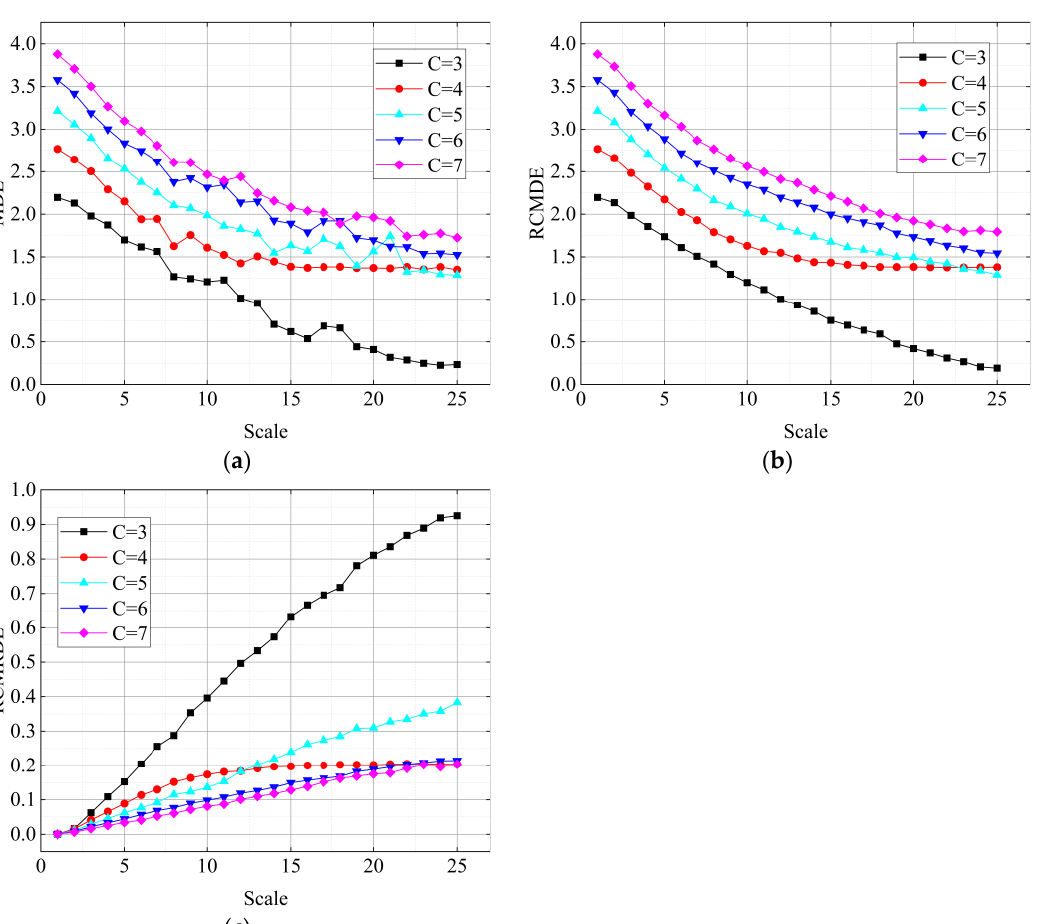
Figure 3. MDE, RCMDE, RCMRDE of WGN noise under different numbers of c ( a ) MDE of WGN; ( b ) RCMDE of WGN; ( c ) RCMDE of WGN.